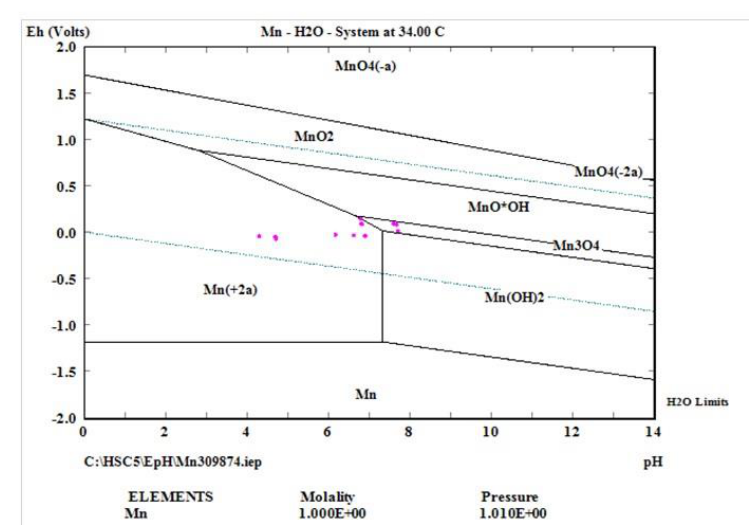
Fig. 5(b): Speciation of Mn in different Eh values in Tehran rainwater samples after the PEC process